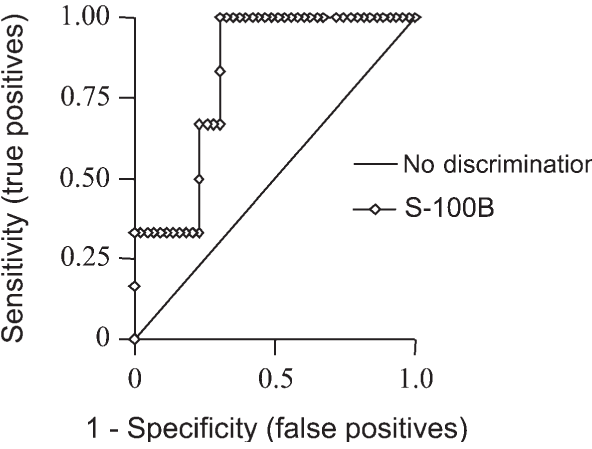
Figure 2 - Receiver operating curve analysis in 50 patients with minor head